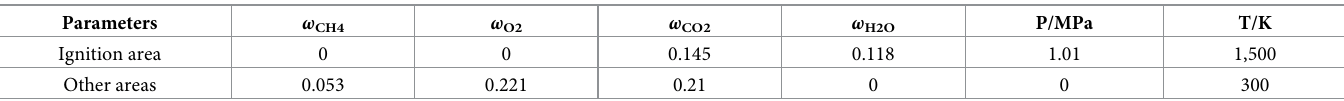
Table 2. Initial parameter setting during numerical simulation. Parameters Other